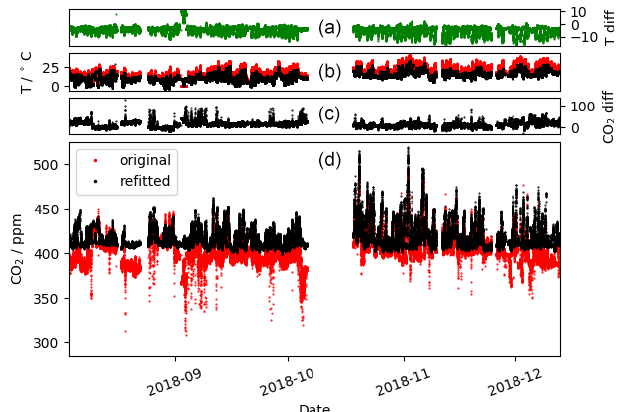
Figure 3. Time series illustrating the impact of re-processing the original spectra to account for contributions from short-path (spuri- ous) reflections and inaccuracies in measured temperature. The fig- ure shows, in order from bottom to top, the original (red) and refit- ted (black) CO 2 (d) , the difference between the refitted and original CO 2 (c) , the measured (red) and fitted (black) temperature (b) , and the difference between the fitted and measured temperature (a)